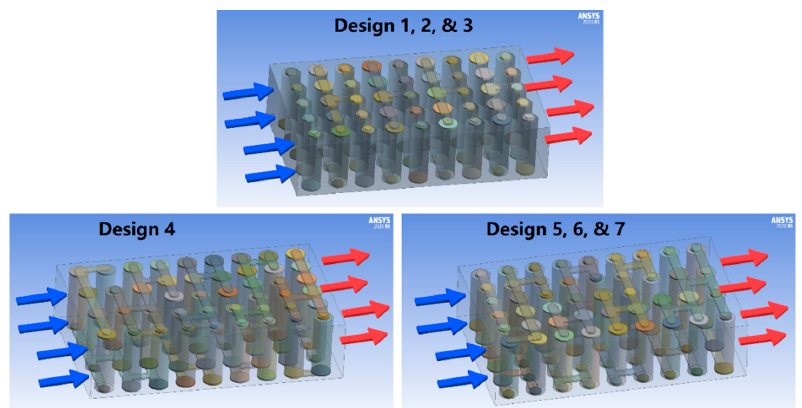
Figure 2. Inlet and outlet configurations of 7